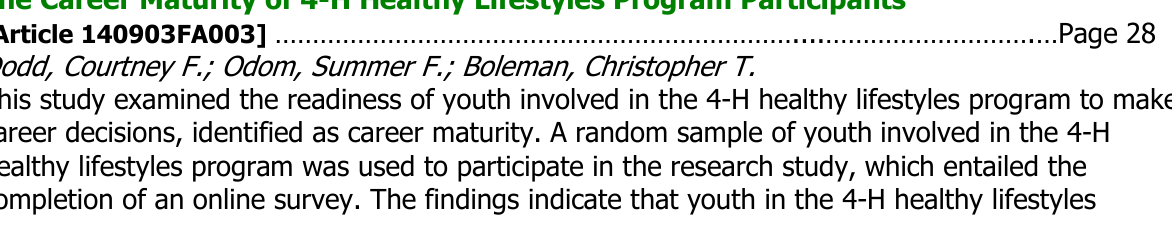
Interdependence: Ninth and Newest Critical Element for 4-H Positive Youth